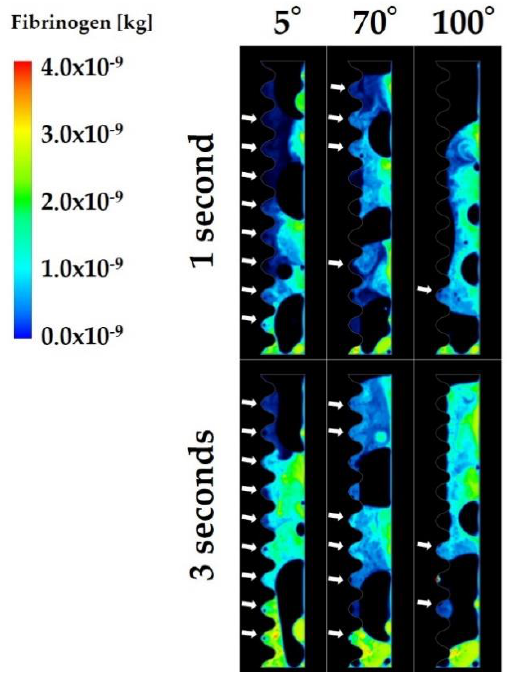
Figure 2. Volume rendering images of the mass of fibrinogen. The white arrows show the threads infiltrated with fibrinogen.